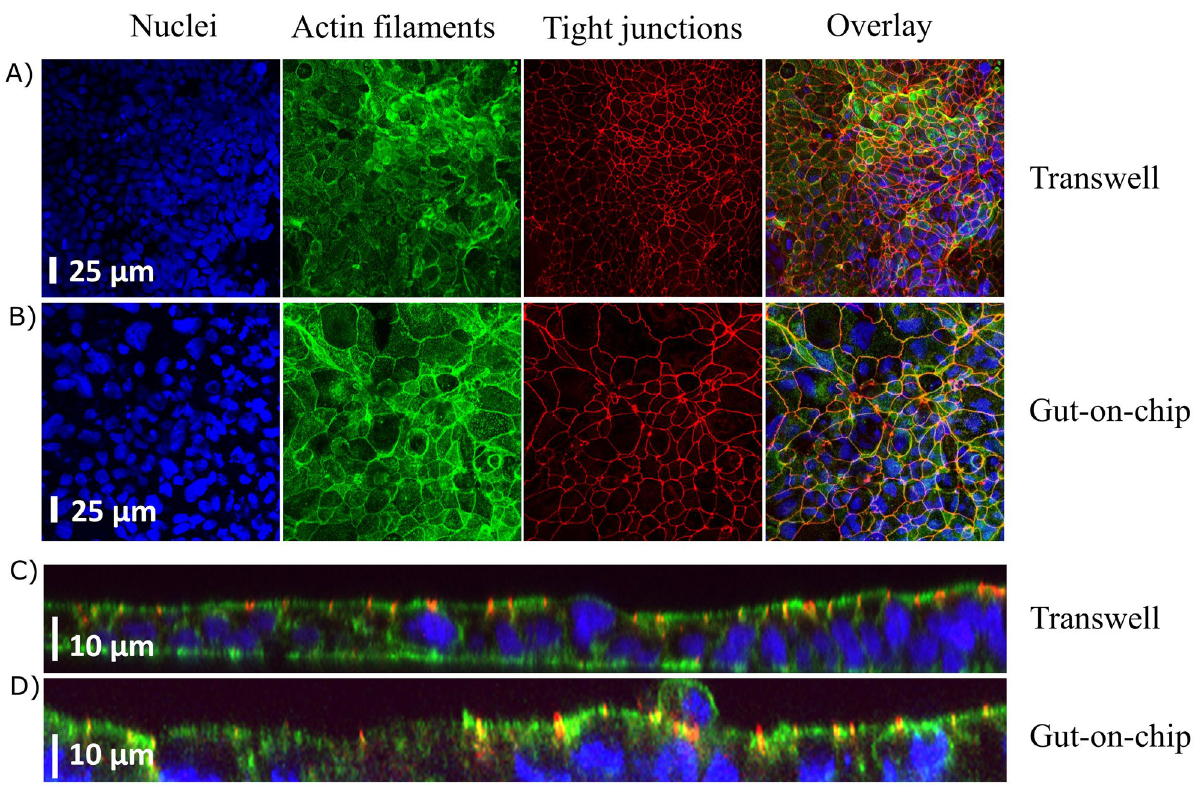
Figure 2. Cell morphology of Caco-2 cells after 21 days of culture under static (Transwell) and dynamic, with a flow of 100 µL/h, (gut-on-chip) conditions, visualized by confocal microscopy. Top views of the cell layer in ( A ) the Transwell and in ( B ) the gut-on-chip. Vertical cross-sections of the cell monolayer in ( C ) the Transwell and ( D ) the gut-on-chip. Actin filaments (Phalloidin) in green, cell nuclei (DAPI) in blue, and tight junctions (ZO-1/ TJP1) in red.